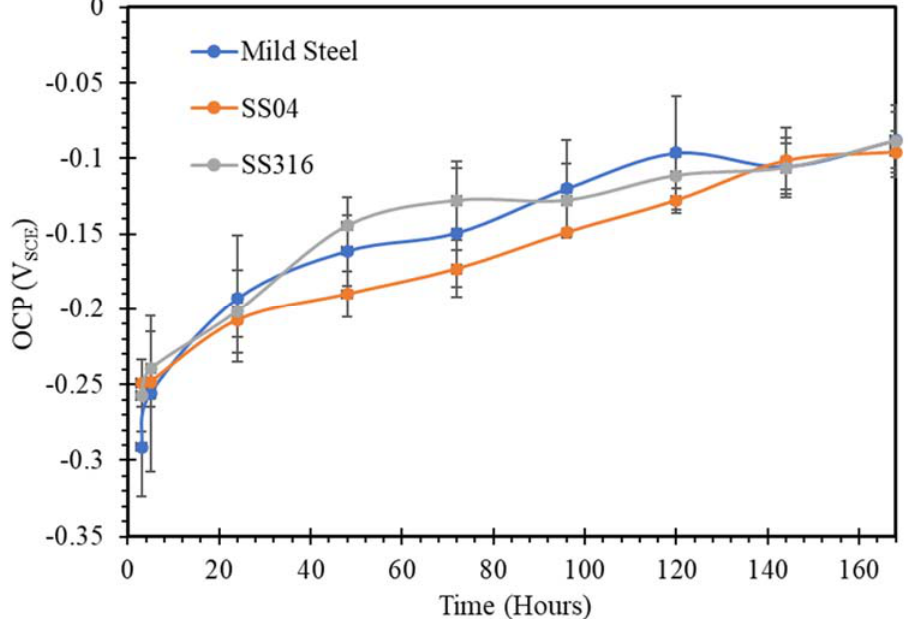
Figure 4. OCP vs. time plots of mild steel, SS304 and SS316 in HPC solution.